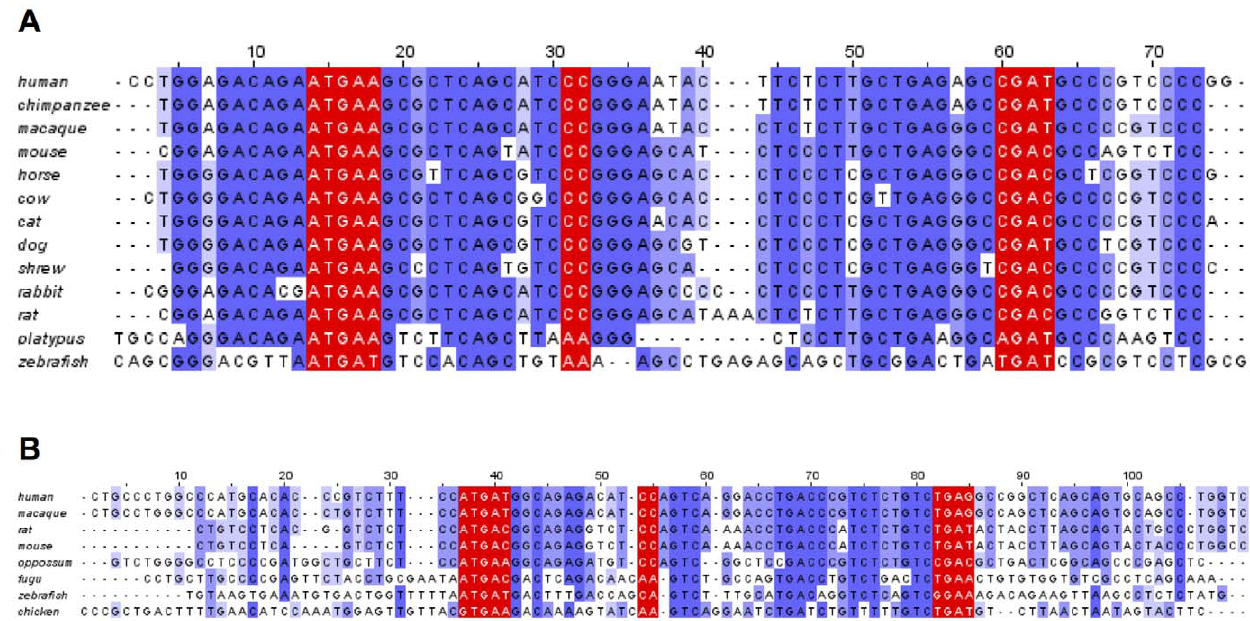
Figure 6. SECIS elements of SelM and SelO. Multiple sequence alignment of SelM (A) and SelO (B) SECIS elements. Critical regions are marked in red.